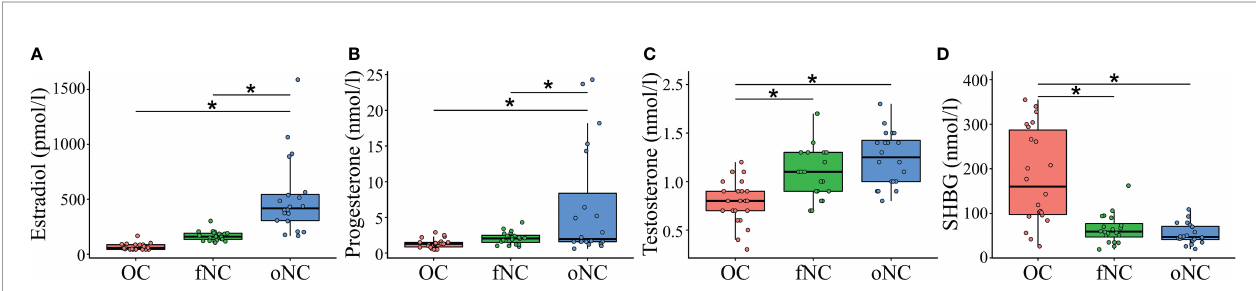
FIGURE 1 | Serum hormone pro fi les for each hormone pro fi le group, showing (A) estradiol in pmol/l and (B) progesterone, (C) testosterone, and (D) sex hormone binding globulin (SHBG) in nmol/l. OC, women using OCs; fNC, women in the early follicular phase; oNC, women during periovulatory phase. Whiskers indicate variability outside the upper and lower quartiles, ‘ * ’ denote signi fi cance levels at p